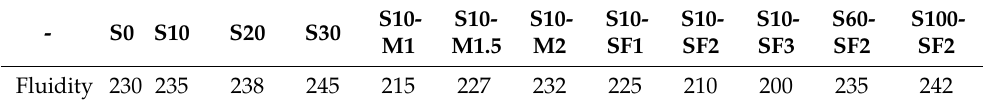
Table 8. Fluidities of slurries